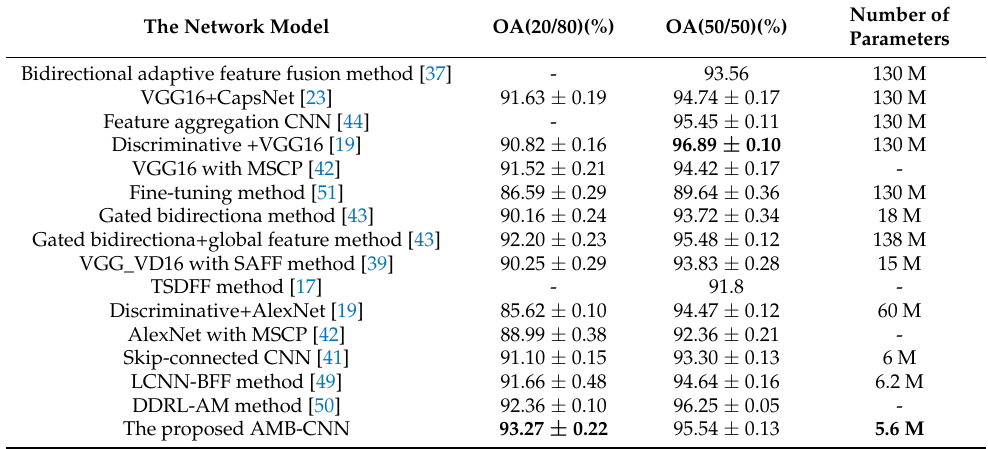
Table 4. Performance comparison of the proposed model with some state-of-the-art methods on the AID30